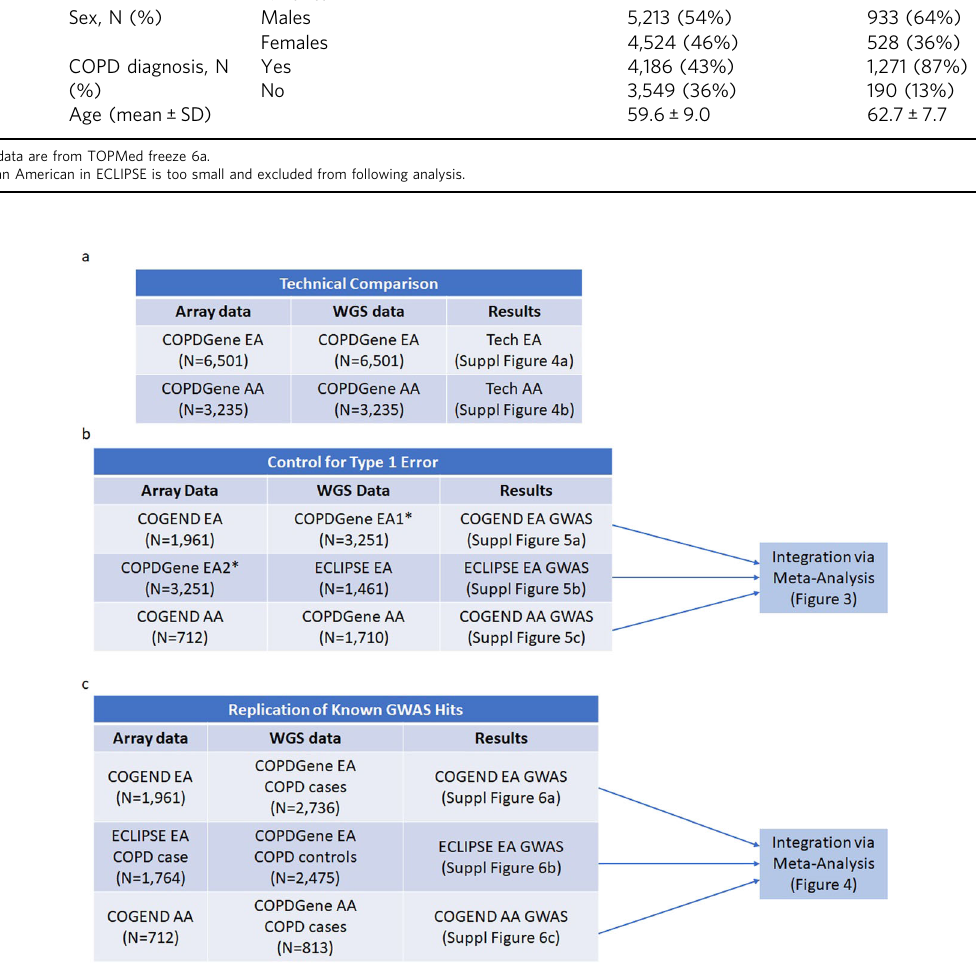
Fig. 2 Evaluation design for GAWMerge. Evaluation design for a technical comparison, b type-I error assessment, and c known GWAS hits. *The samples with European ancestry in COPDGene were evenly divided into two subsets of samples. EA1 includes all COPD cases and some COPD controls to match the COPD prevalence in ECLIPSE. EA2 has all the rest COPD free samples.